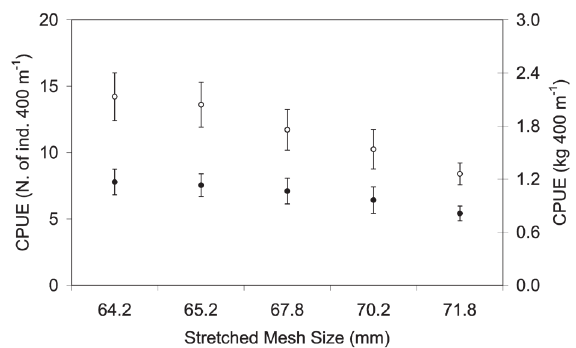
Fig . 2. – Gill net catches: Catch per Unit Effort (± standard error) of S. solea in number of individuals (white dots) and weight (black dots) per 400 m of gill net.